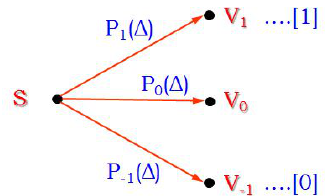
Fig. 5. Mapping of the RCS: Received signal sample maps to chip-decision.